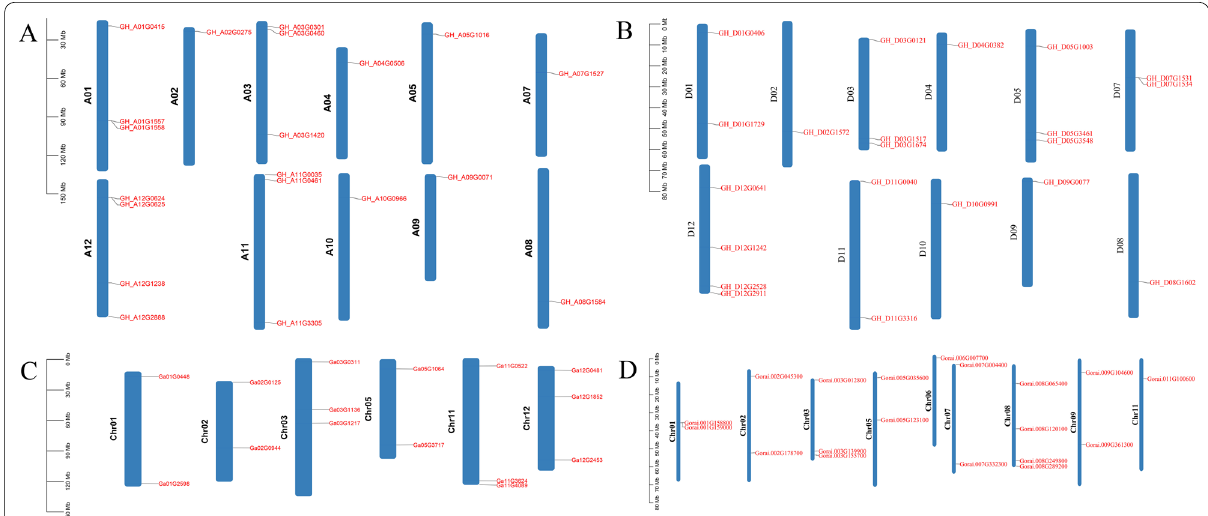
Fig. 5 Chromosomal mapping of cotton MAPK genes. A ) GHMAPK At subgenome; B ) GHMAPK Dt subgenome; C ) GaMAPK ; D ) GrMAPK . Chromosome number is indicated on the middle of the left-hand side of the